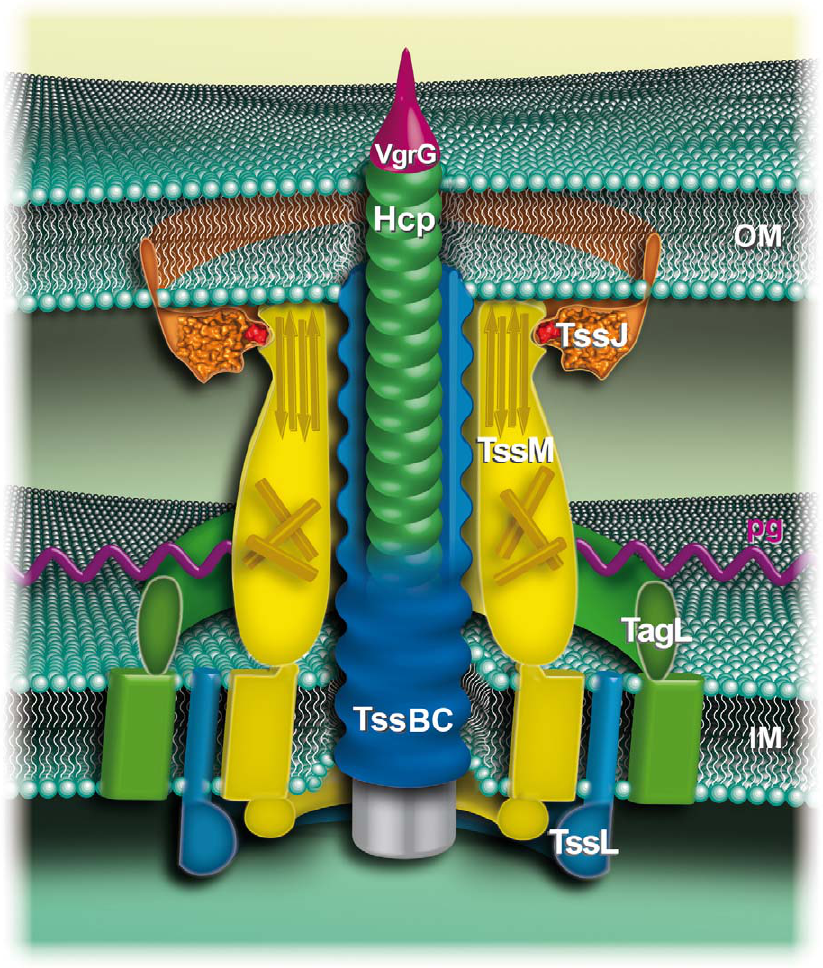
Figure 5. Schematic representation of the enteroaggregative E.coli T6SS. The outer (OM) and inner membranes (IM) are represented in light green. The T4 phage-like central puncturing device includes Hcp (green disks) and VgrG (purple). The ‘‘tail sheath’’ TssBC (VipAB) proteins are shown in blue, around the central Hcp/VgrG pilum. The TssBC proteins constituting a sheath encompassing the Hcp tube has not been evidenced but is speculated based on the similarities between the T6SS TssBC subunits and the bacteriophage T4 sheath [4,17]. The three-transmembrane inner membrane TssM protein (yellow) interacts with the TssL IM protein (blue) [20]. TssL interacts with TagL (green), an IM protein that anchors the T6SS to the cell wall [22]. TssM C-terminal domain interacts with a loop of the outer membrane lipoprotein TssJ [this study]. In this model, the TssL-TagL- TssM-TssJ complex forms a trans-envelope spanning channel.